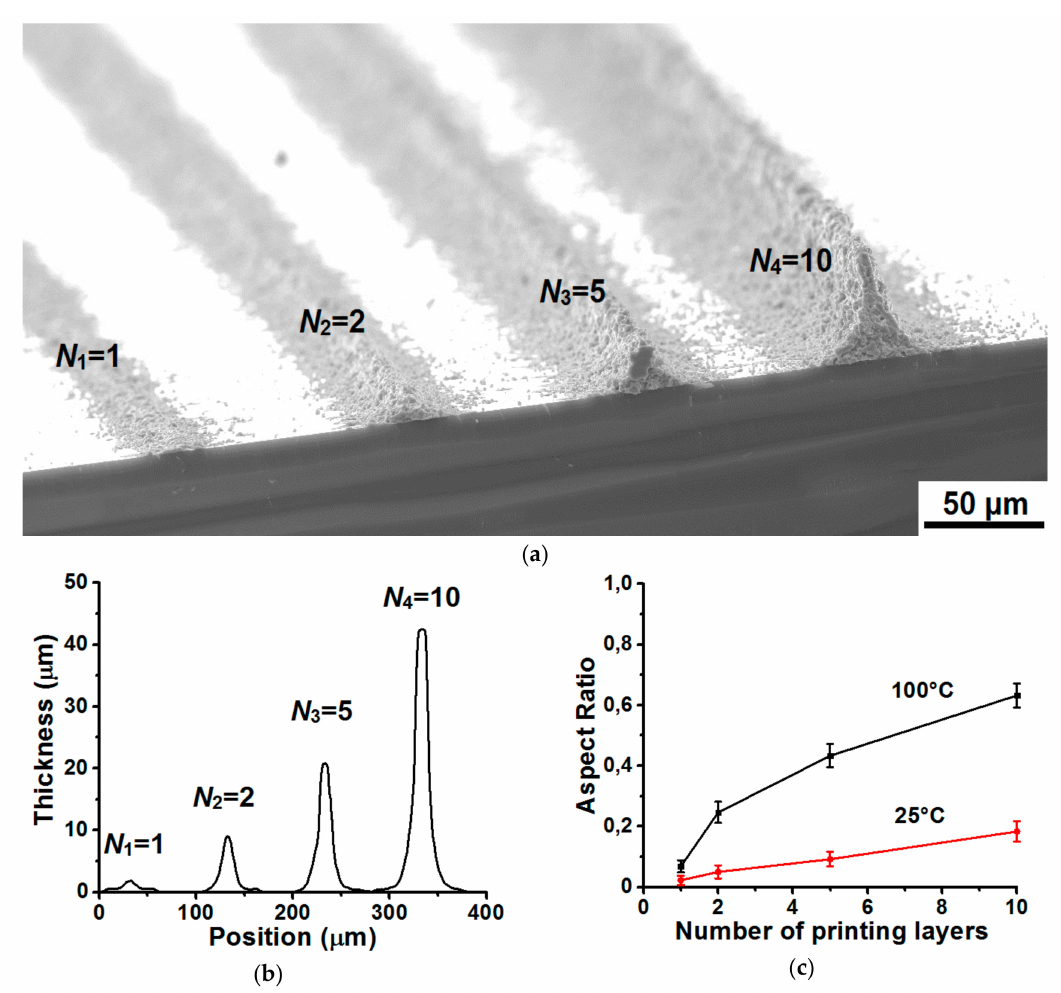
Figure 4. SEM image of silver lines formed by aerosol jet printing on heated silicon substrate at T s = 100 ◦ C with a change in the number of printing layers N from 1 to 10, where V and FR = 5 ( a ) and their relevant cross-sectional profiles measured on an optical profilometer ( b ). The dependence of the values of the aspect ratio of lines on the number of printing layers N is from 1 to 10 when printing on heated substrate at T s = 100 ◦ C and on unheated substrate at T s = 25 ◦ C ( c